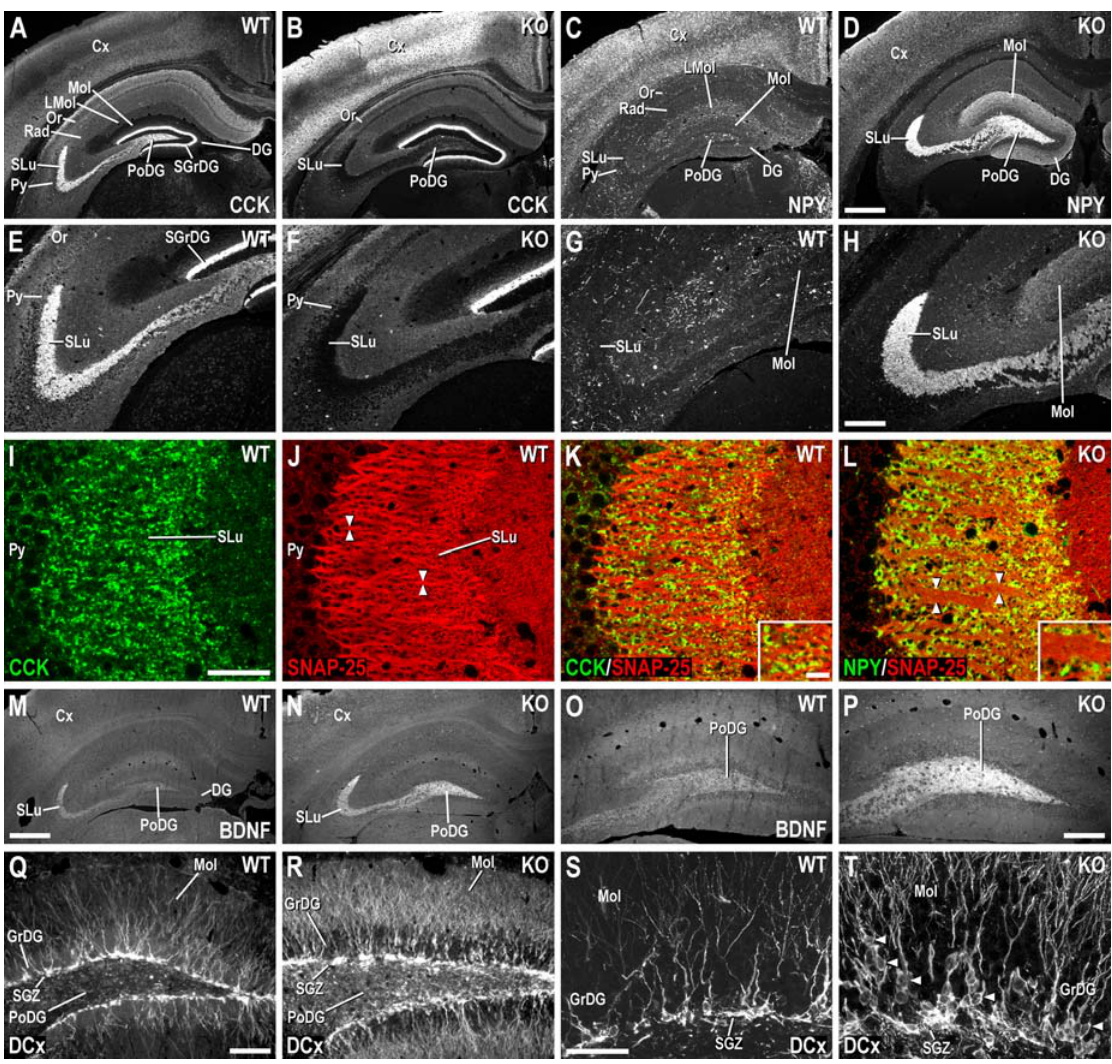
Figure 6. SNAP-25, CCK, NPY, BDNF, and DCx Immunoreactivity in the Hippocampal Formation of Adult Neo -excised SNAP-25b Deficient and WT Mice. (A) CCK-ir in HF of WT mice, shown at higher magnification in (E). In SNAP-25b deficient mice (B), CCK-ir disappears in PoDG and SLu, higher magnification in (F). (C) NPY-ir in WT HF, shown at higher magnification in (G). (D) Increased NPY-ir in PoDG, Mol, and SLu of SNAP-25b deficient (KO) mice, the latter at higher magnification in (H). Confocal micrographs of double-staining experiments taken from WT (I-K), and neo -excised SNAP-25b deficient (L) mice. CCK- (I) and SNAP-25-ir (J) in fibers/terminals of SLu in WT mice. Arrowheads in (J) point to strong SNAP-25 + fibers. (K) Double-staining of CCK- (green) and SNAP-25-ir (red) in WT SLu. (L) NPY-ir, lacking in fibers/terminals of WT SLu, is highly expressed in neo - excised SNAP-25b deficient mutants. In homozygous neo -excised SNAP-25b deficient mice, SNAP-25-ir fibers in SLu are often thicker (arrowheads in (L) compared to WT mice [(L) cf. (J,K)]. Insets in (K,L) show respective photomicrographs at higher magnification. (M) BDNF-ir in WT HF, the PoDG, and SLu shown at higher magnification in (O). (N) Increased BDNF-ir in PoDG and SLu of mutant mice, the DG shown at higher magnification in (P). (Q) Strong DCx + cell bodies in SGZ of WT DG, shown at higher magnification in (S). (R) Increased number of cell bodies randomly distributed in SGZ and granular cell layer of neo -excised SNAP-25b deficient mutants, with higher levels of DCx + fibers in Mol, shown at higher magnification in (T). Arrowheads in (T) point to DCx + cell bodies in the granular cell layer. Cx, cortex; DG, dentate gyrus; LMol, lacunosum Mol; Mol, molecular layer of DG; Or, oriens layer of HF; PoDG, polymorph layer of DG; Py, pyramidal layer of HF; Rad, stratum radiatum of HF; SGrDG, supragranular layer of DG; SGZ, subgranular zone of DG; SLu, stratum lucidum of HF. Scale bars: (D=A–C=500 m m), (H=E–G=200 m m), (I=J–L=50 m m), (K, inset=L inset=10 m m), (M=N=500 m m), (O=P=200 m m), (Q=R=100 m m), (S=T=50 m m). WT (n=2), SNAP-25b mutant mice (n=2).